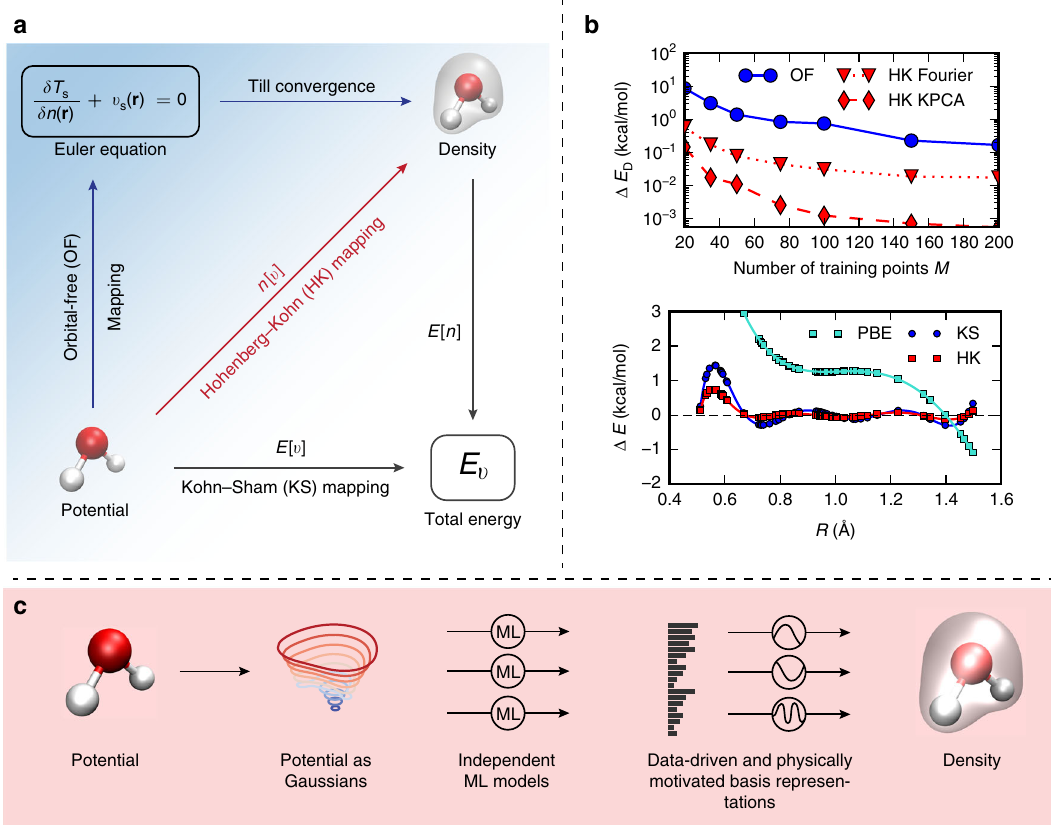
Fig. 1 Overview of approach and motivation. a Mappings used in this paper. The bottom arrow represents E [ v ], a conventional electronic structure calculation, i.e., KS-DFT. The ground-state energy is found by solving KS equations given the external potential, v . E [ n ] is the total energy density functional. The red arrow is the HK map n [ v ] from external potential to its ground state density. b ( Top ) How the energy error depends on M , the number of training points, for ML-OF and ML-HK with different basis sets for the 1D problem. b ( Bottom ) Errors in the PBE energies (relative to exact values) and the ML maps (relative to PBE) as a function of interatomic spacing, R , for H 2 with M = 7. c How our Machine Learning Hohenberg – Kohn (ML-HK) map makes predictions. The molecular geometry is represented by Gaussians; many independent Kernel ridge regression models predict each basis coef fi cient of the density. We analyze the performance of data-driven (ML) and common physical basis representations for the electron